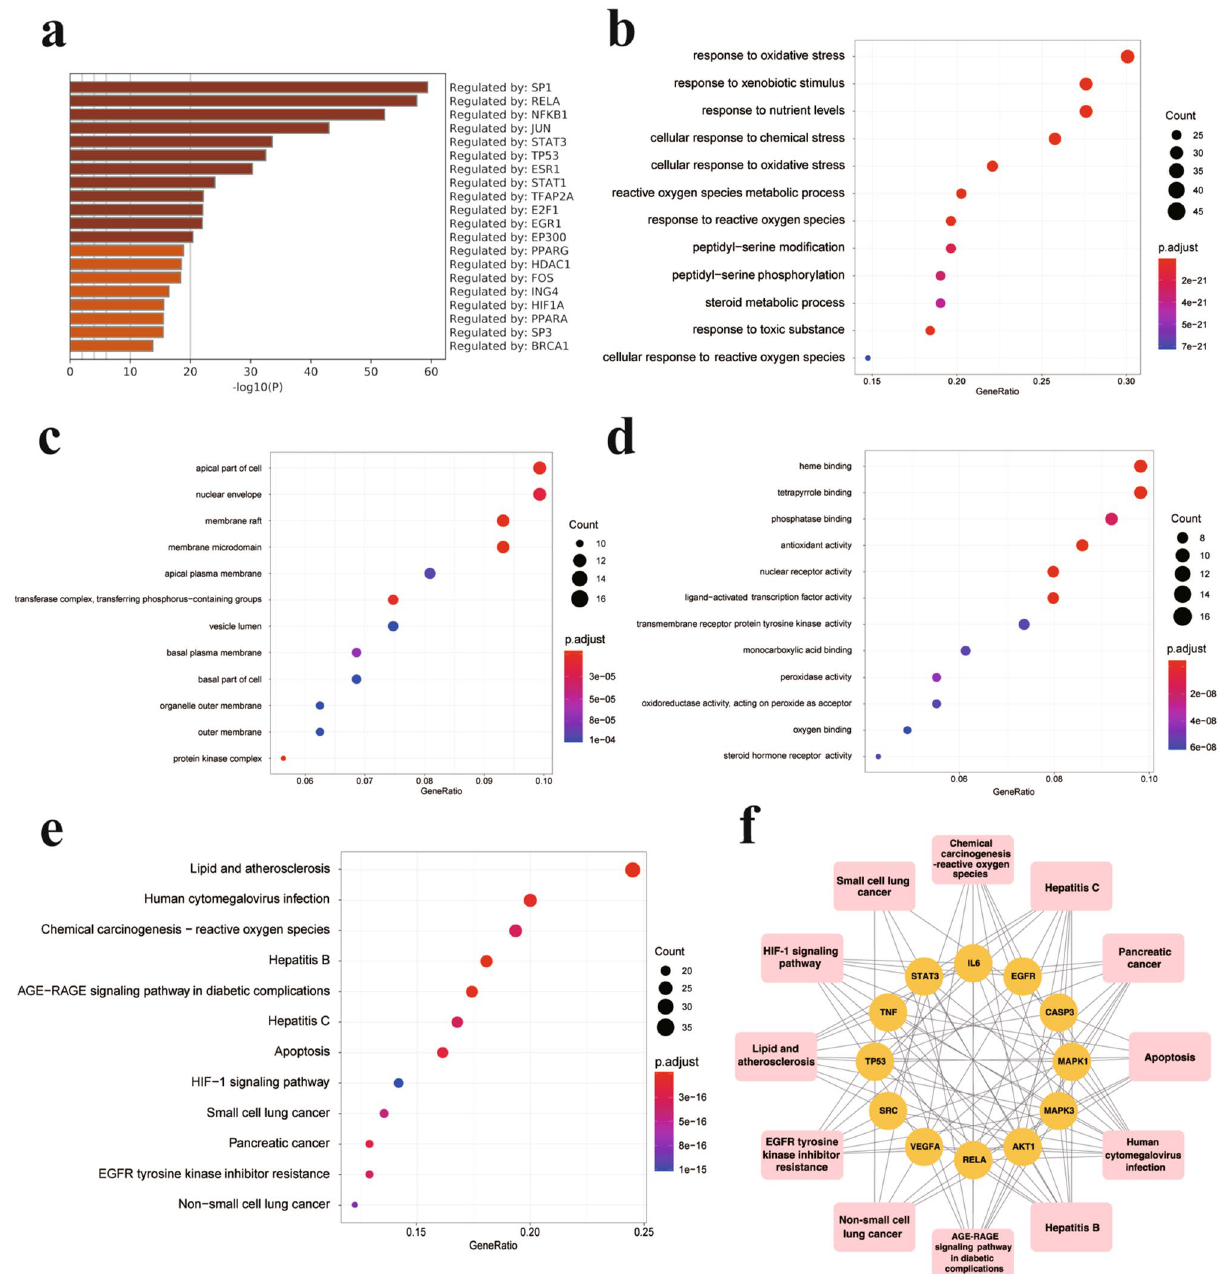
Figure 3. Enrichment analysis of naringenin in the treatment of chronic wounds. ( a ) TF enrichment analysis of 163 overlapping genes in the TRRUST database using Metascape. The bubble diagrams show the terms in the ( b ) biological process (BP), ( c ) cellular component (CC) and ( d ) molecular function (MF) categories in the GO analysis of 163 overlapping genes for the treatment of chronic wounds with naringenin. ( e ) The top 12 enriched KEGG pathways are highlighted in the bubble diagram. ( f ) The relations between the top 12 KEGG pathways and the key targets of